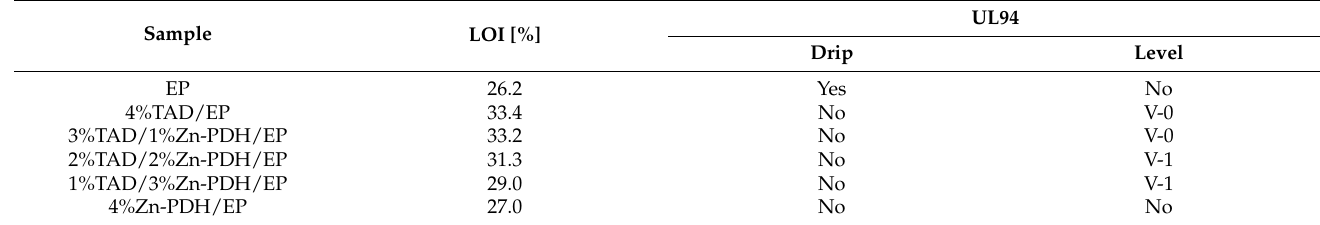
Table 3. LOI values and UL94 levels of epoxy resin